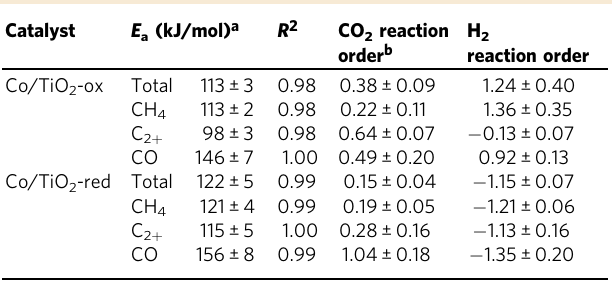
a E a was calculated with six data points at T = 200 – 280°C and P = 20bar. The R 2 values of the trendlines are reported in the third column. b CO 2 and H 2 reaction orders were determined at T = 250°C and P =